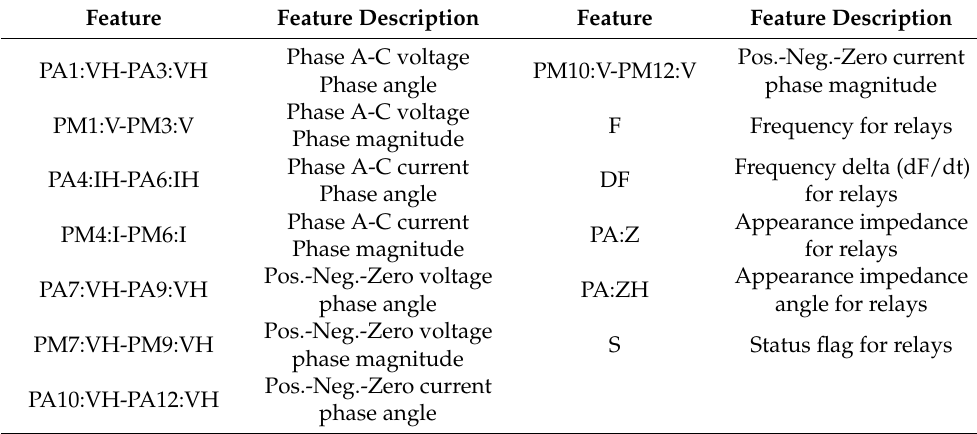
Table 2. Original dataset features and feature descriptions.